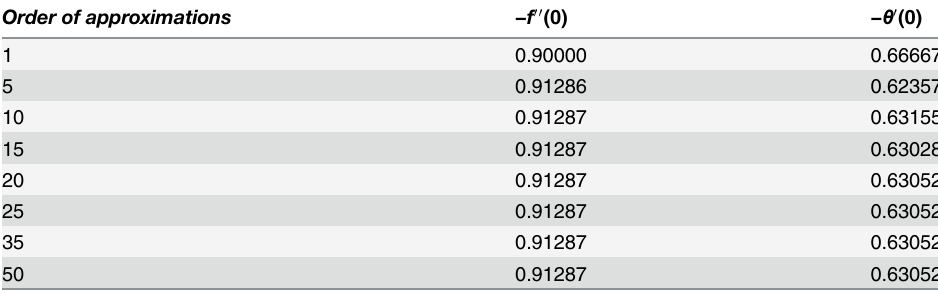
Table 2. Convergence of homotopic solutions in second grade fluid for various order of homotopic approximations when k (cid:3) 1 ¼ (cid:2) 0 : 2 ; γ = 0.3 and Pr = 1.0. Order of approximations